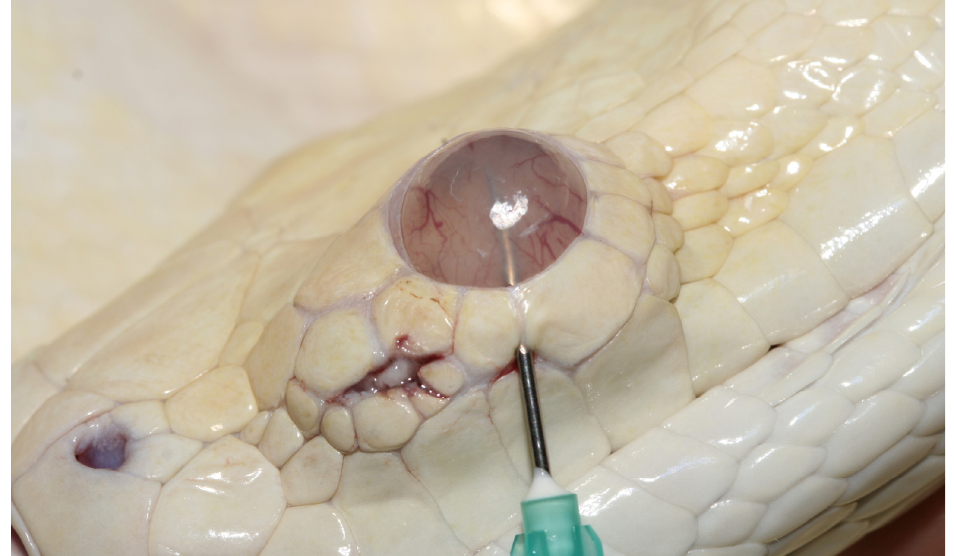
Figure 37. Sampling of a subspectacular abscess in a Burmese python ( Python bivittatus ) via fine needle aspiration by insertion of the needle in between the periocular scales.